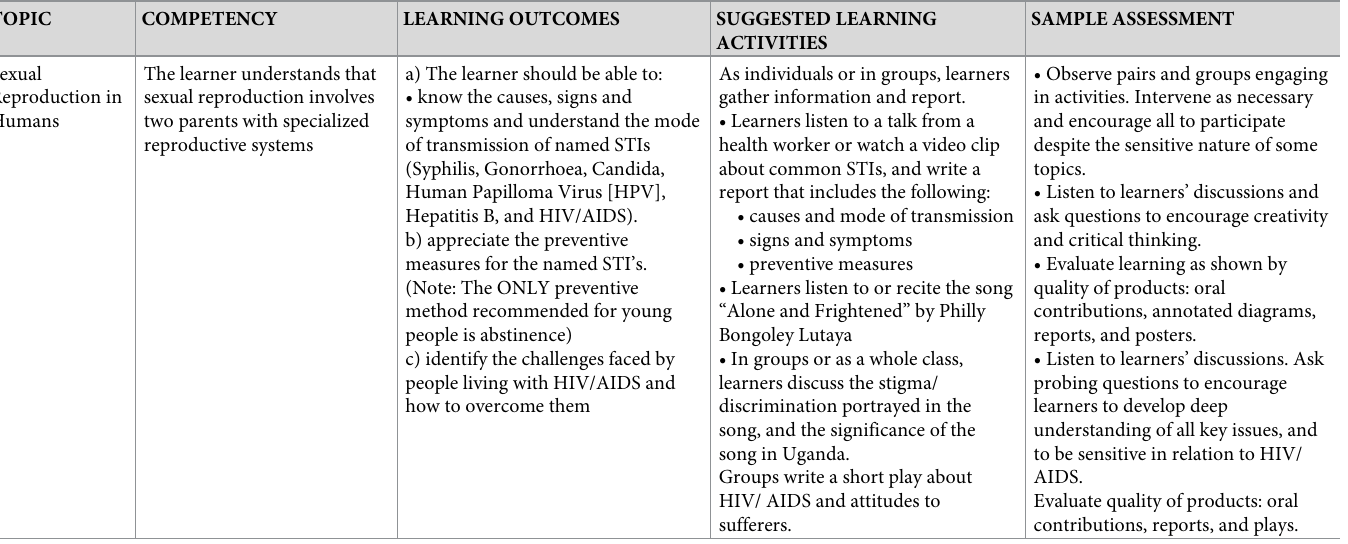
Table 3. Example of a learning outcome with suggested activities and assessments from the